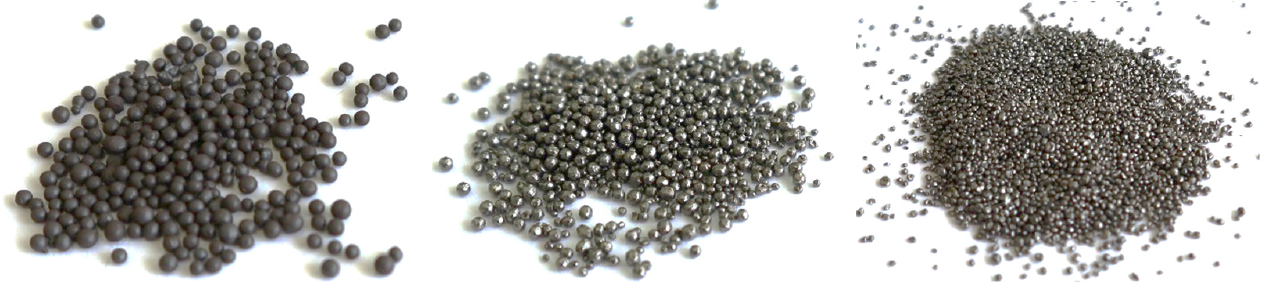
Figure 2. New ( left ), operational ( center ), and worn ( right ) shots.